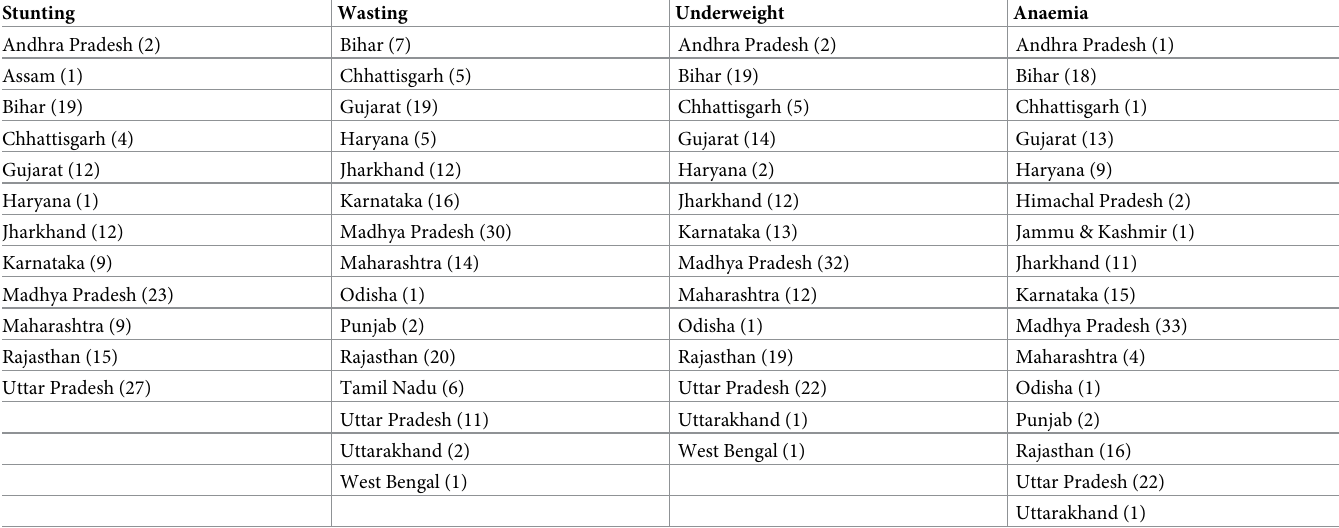
Table 5. Number of districts by state which have child malnutrition levels higher than India average in districts categorized as “high” or “very high” in degree of vulnerability.